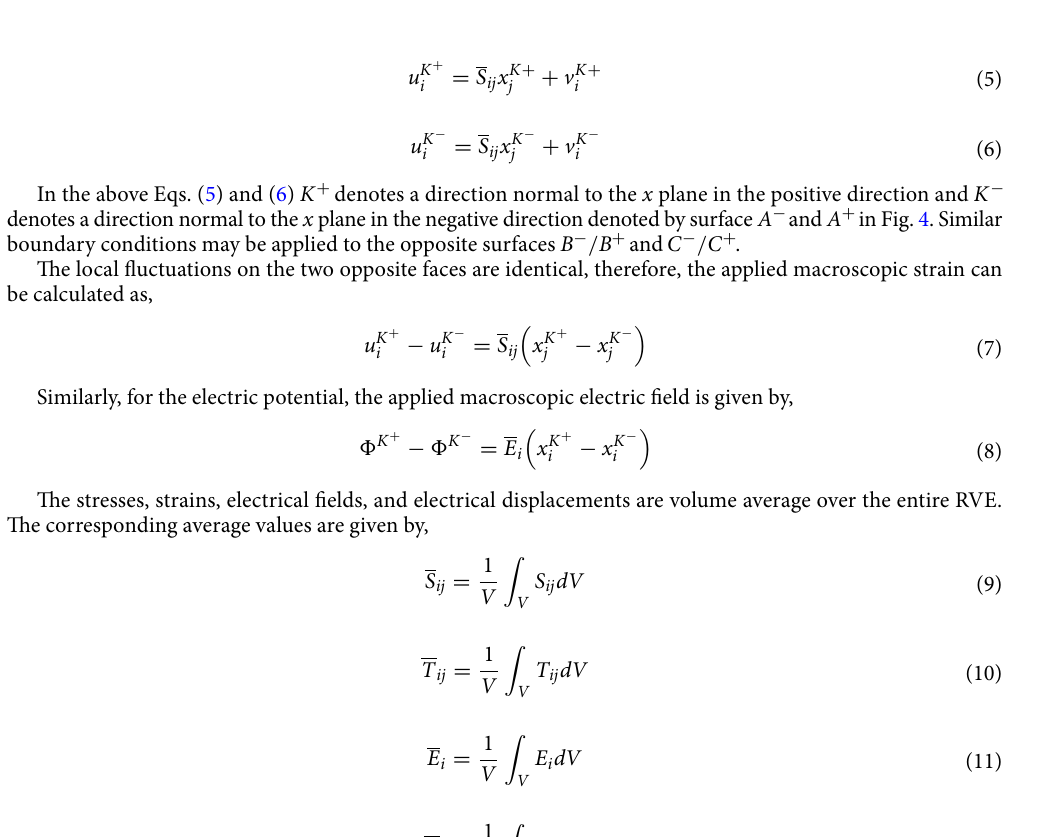
Table 1. Equations and boundary conditions to calculate effective